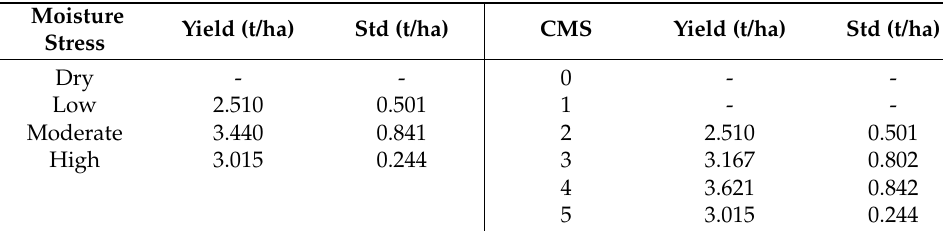
Table 2. Comparison between moisture stress in July and CMS for sunflower